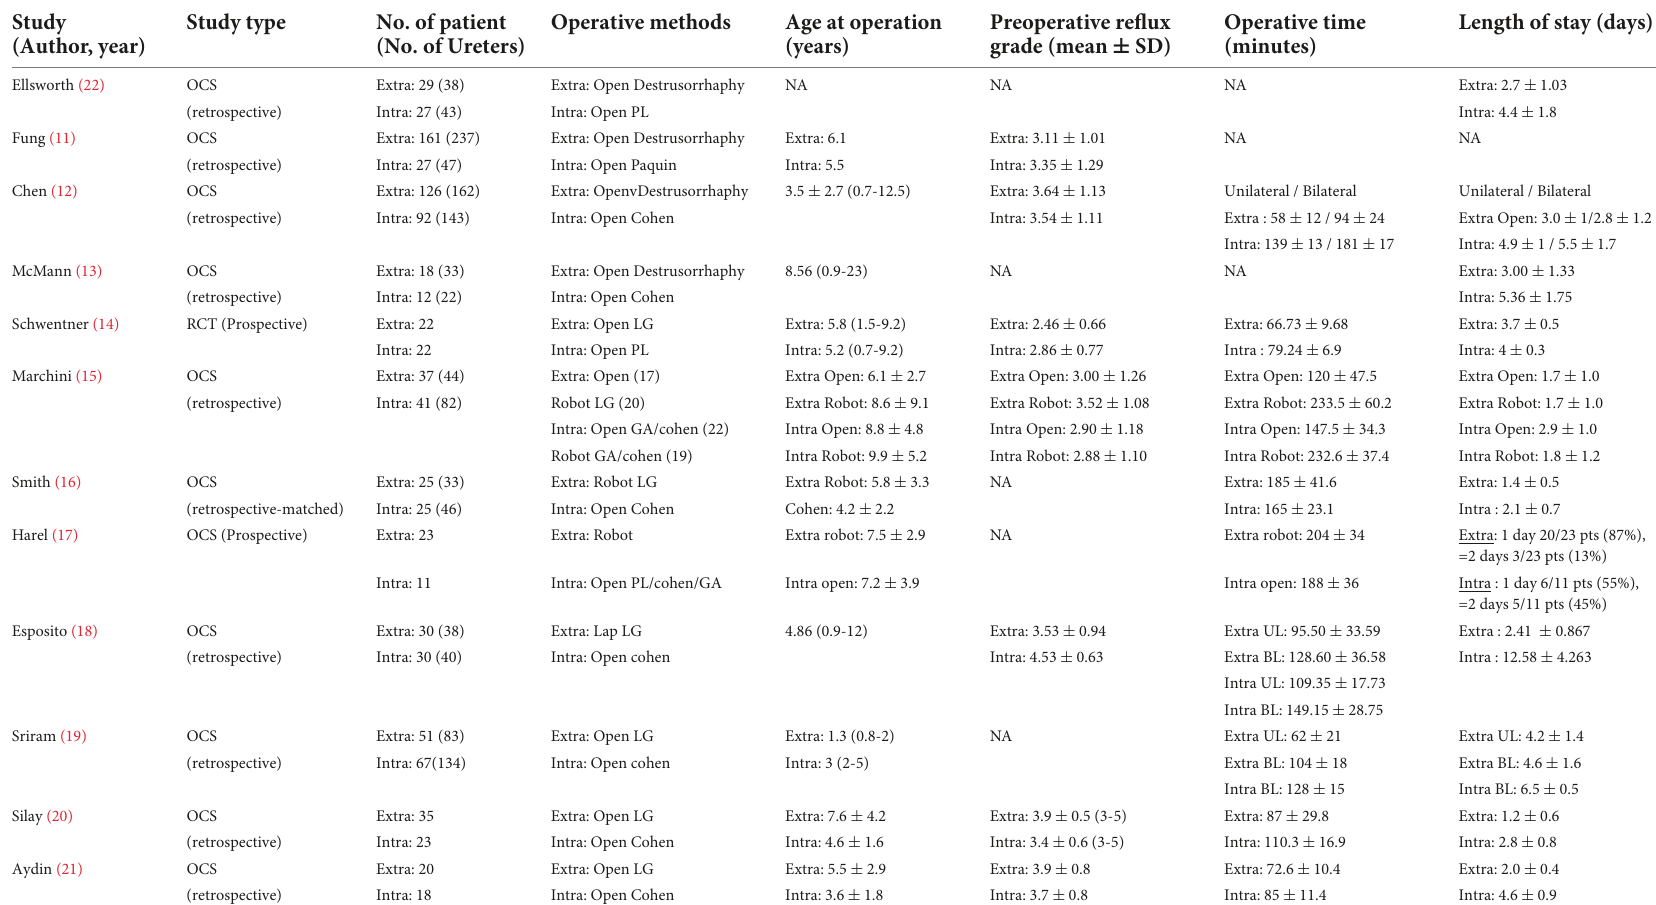
TABLE 1 Characteristics and outcome of studies included in the meta-analysis.